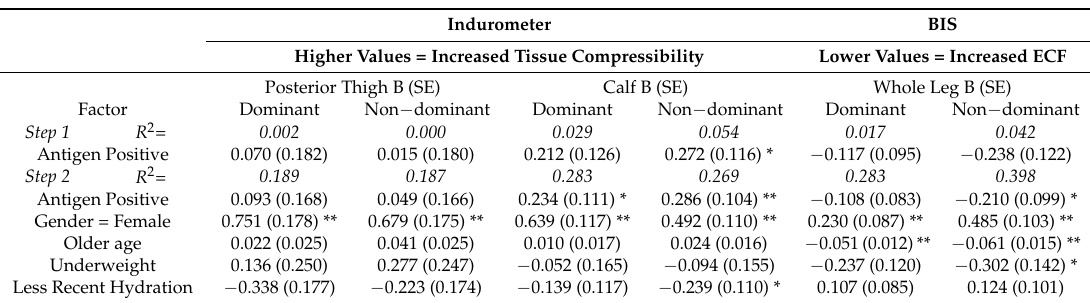
Table 3. Stepwise regression for moderating factors associated with variation in Indurometer and bio-impedance spectroscopy (BIS)